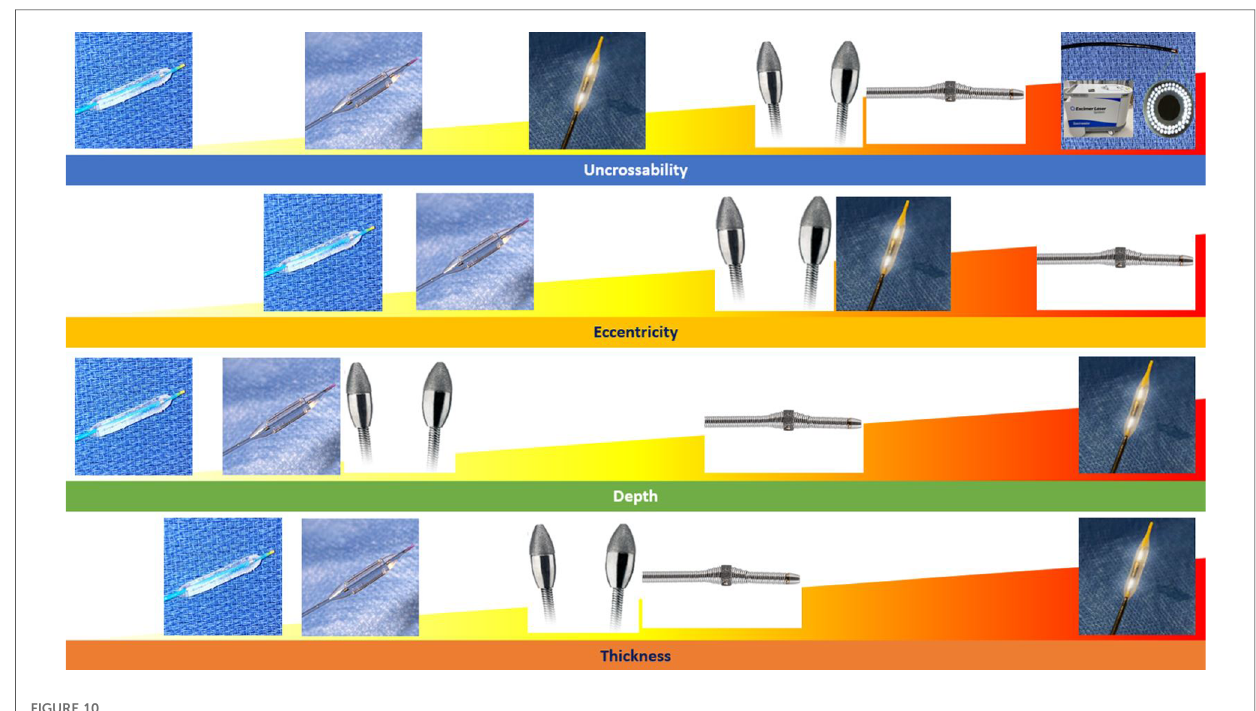
FIGURE 10 Summary of coronary artery calci fi cation modi fi cation tools and most appropriate calci fi cation patterns for their